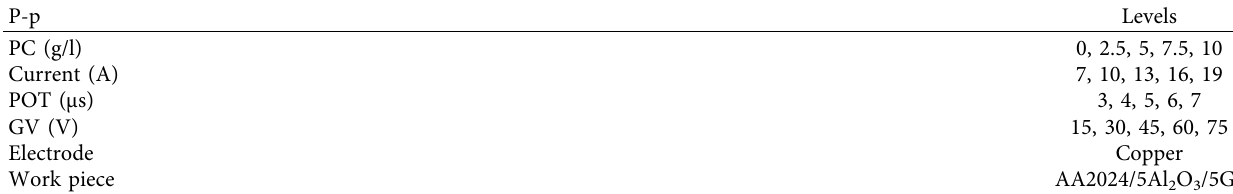
Table 2: Levels of EDM p-p.